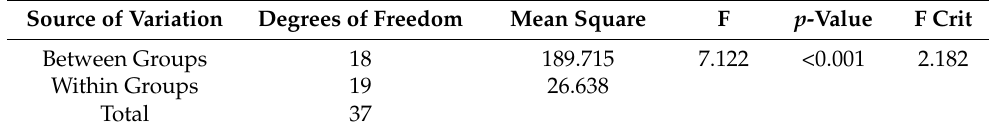
Table 10. Analysis of variance of total glucan content in a panel of 19 mushroom-based supplements between the mean values determined on 5 different capsules and the mixture derived from 5 capsules. Source of Variation Degrees of Freedom Mean Square F p -Value F Crit Between Groups 18 189.715 7.122 <0.001 2.182 Within Groups 19 26.638 Total